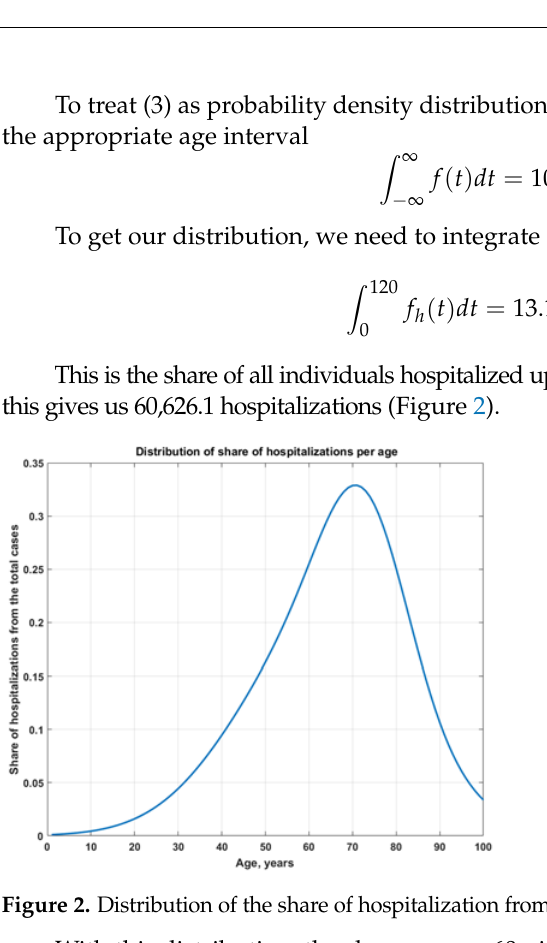
Figure 1. Probability density function of new cases by age for total cases up to 3 September 2021.